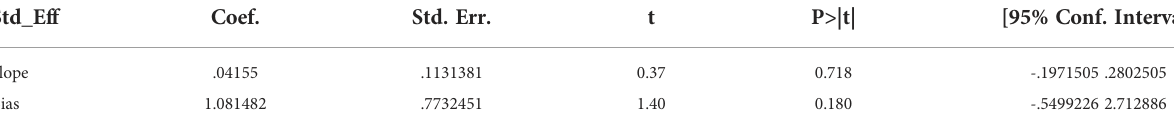
TABLE 3 Egger and Begg tests.